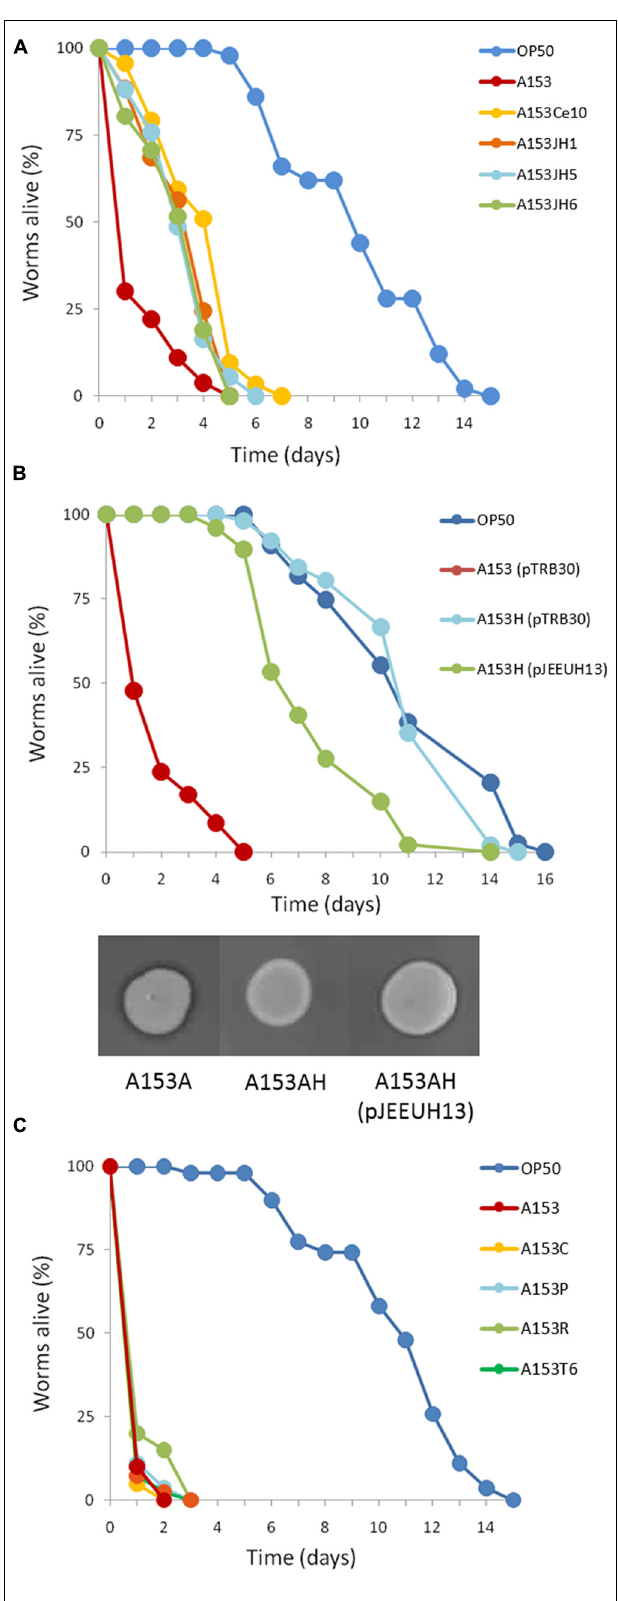
identical at the DNA level with the A153 zmn gene cluster (Table S3). In silico analyses showed that the A153 and RVH1 zmn gene clusters have the same gene and domain organization ( Figure 4B